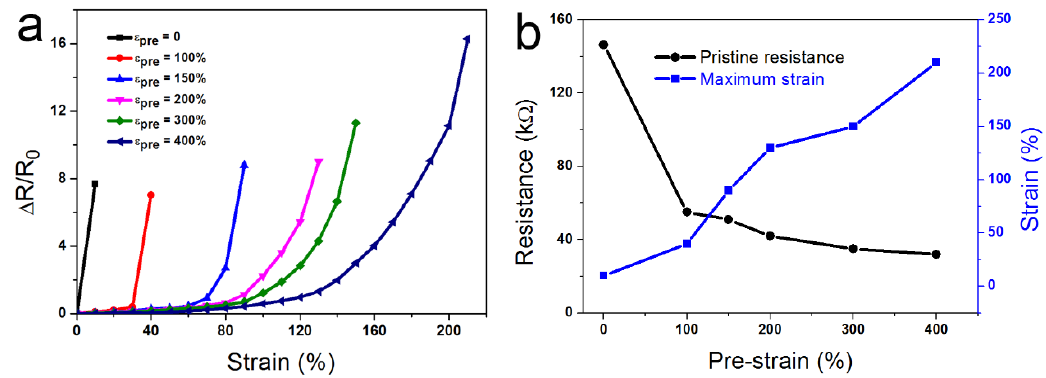
Figure 4. The electromechanical properties of various strain sensors. ( a ) The relationship between the resistance variation and strain with various pre-strains. ( b ) The resistance and the maximum endurable strain comparison of various strain sensors with different pre-strains. Table 1. Comparison of various strain sensors with different pre-strains.